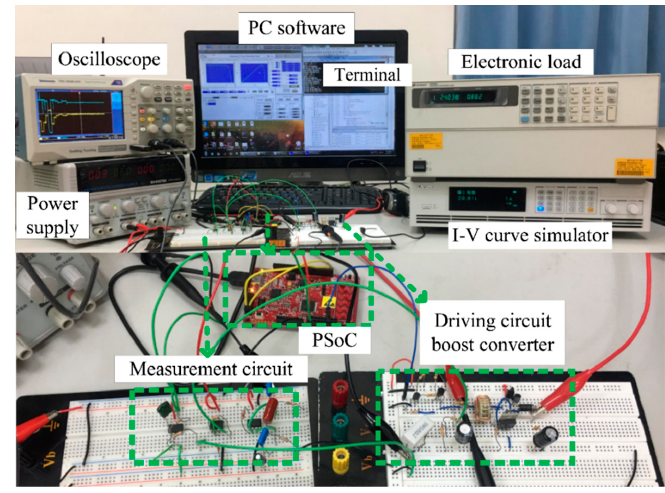
Figure 16. Photograph of the evaluation system.